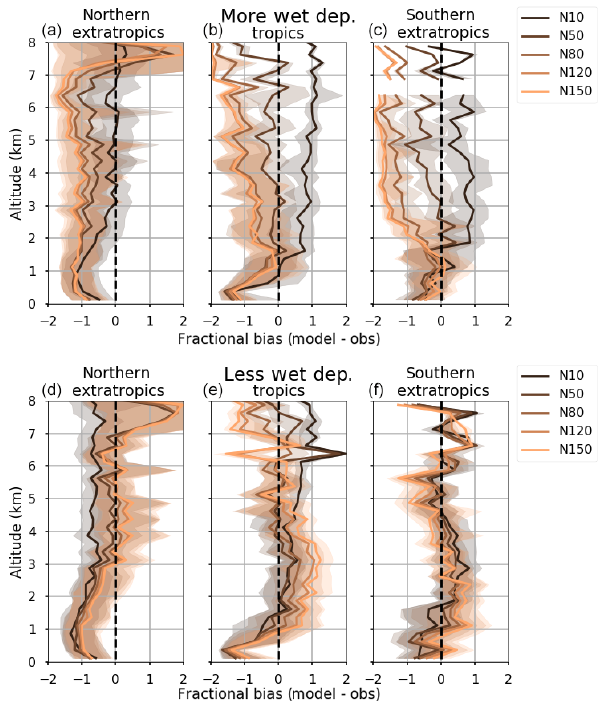
Figure 8. The vertical profile of fractional bias in modelled aerosol number at different size cut-offs for measurements in the northern extratropics (a) , the tropics (b) and the southern extratropics (c) with increased (by a factor of 2) and decreased (by a factor of 0.5) wet deposition